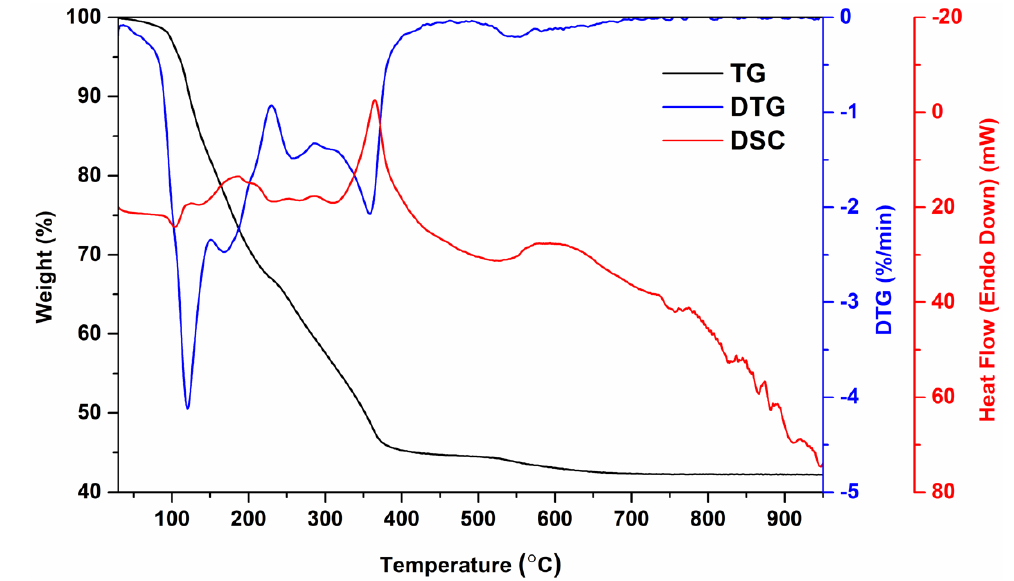
Figure 2. TG–DTG–DSC curves of dried Bi–La–Fe–Sc–O precursor solution.